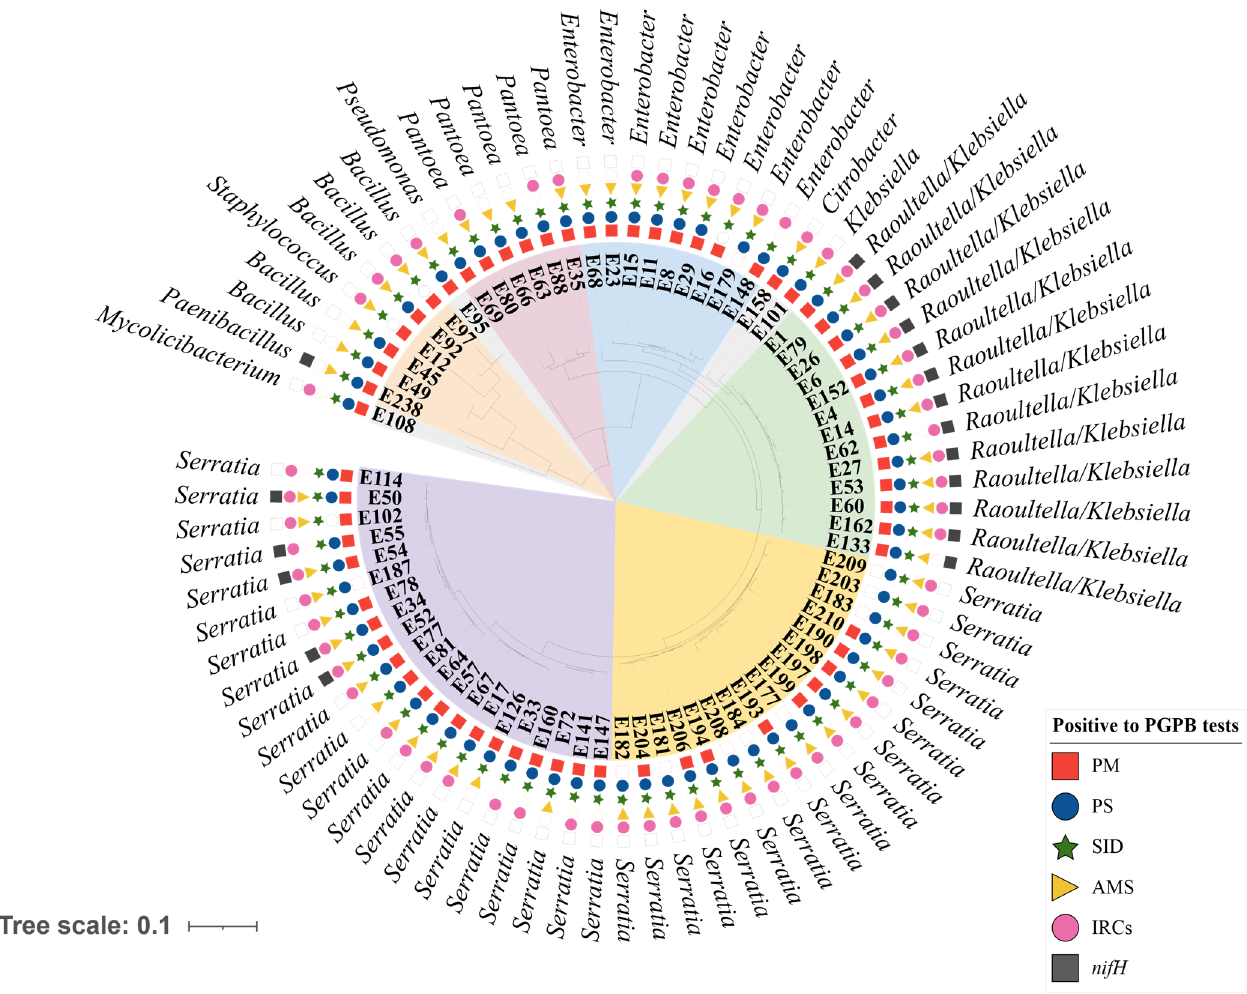
Figure 4. Phylogenetic tree of 16S rRNA sequences from bacterial strains isolated from the Tropaeolum majus endosphere, including the metadata related to the plant growth-promoting tests and their closest molecular identification. The phylogenetic tree was constructed with MEGA X software using the maximum likelihood method, and the metadata were added with iTOL v6 software. PM—phosphate mineralization, PS—phosphate solubilization, SID—siderophore production, AMS—production of antimicrobial substances, IRCs—production of indole-related compounds, and nifH —presence of the nifH gene.